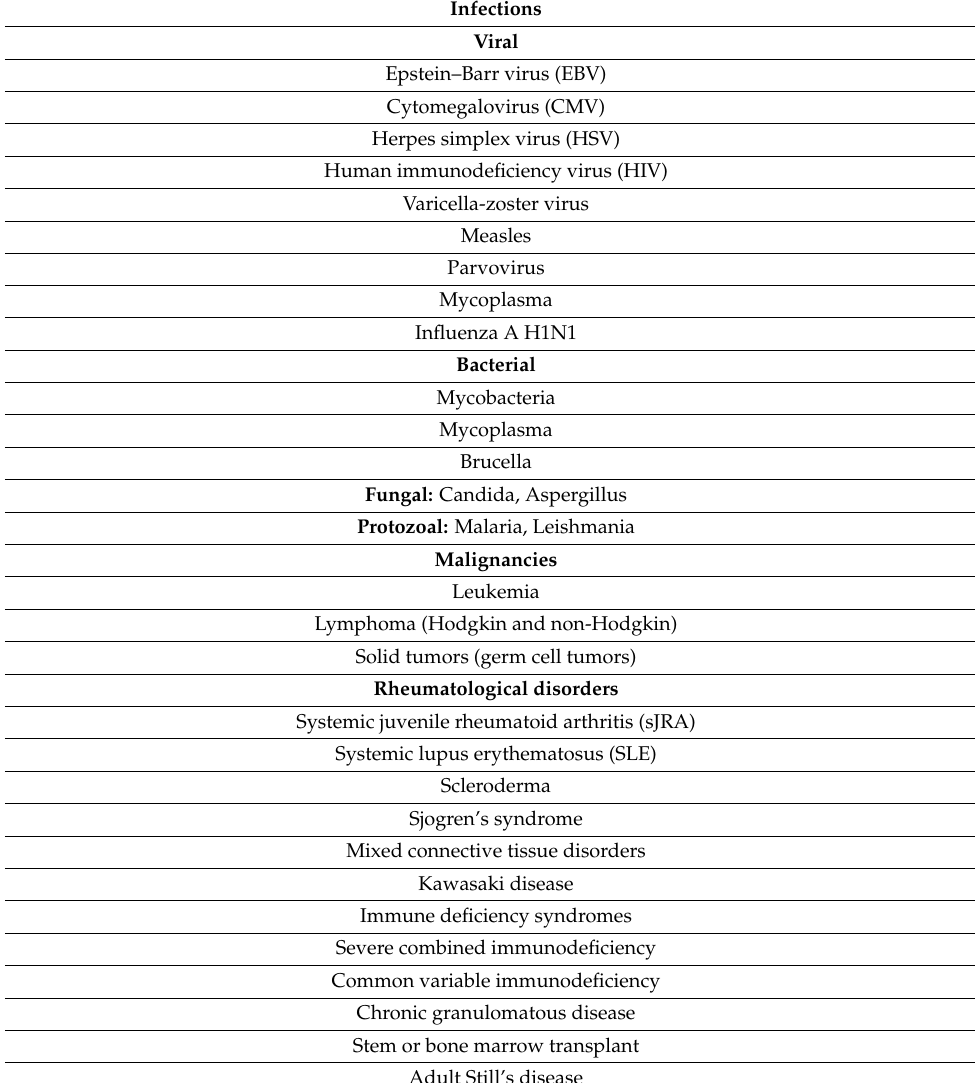
Table 2. Common etiologies associated with HLH